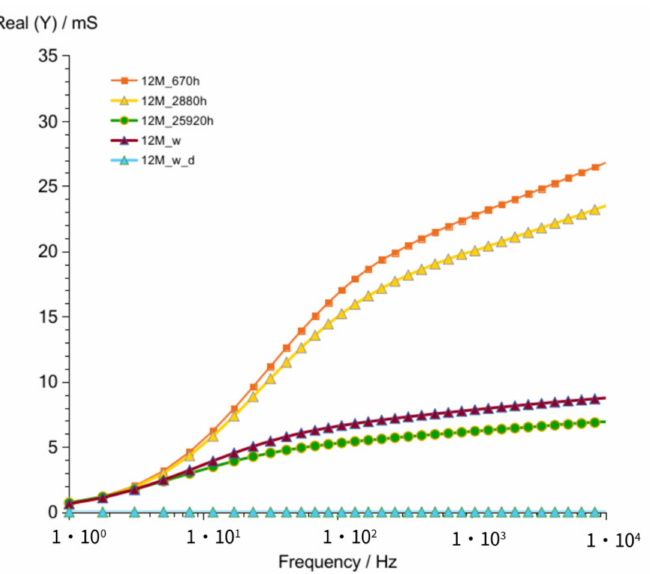
Figure 14. Admittance of G12M geopolymer concrete taken after 670 to 25,920 h from starting polymerization after removing conductive ions (G12M_w) and drying concrete